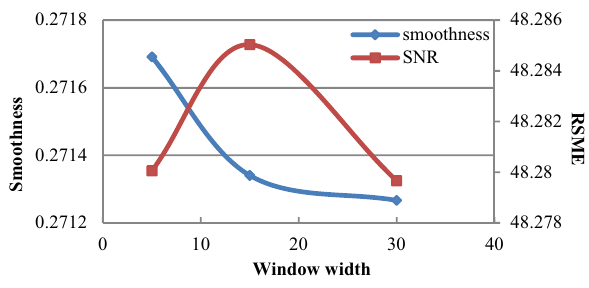
Fig. 7 Processing results of different smoothing window